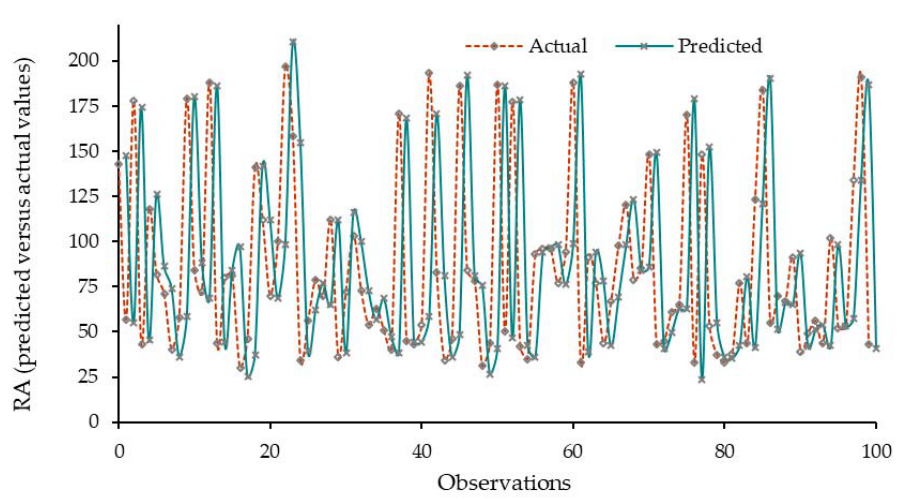
Figure 4. Scatter plot of the actual values and predicted values for one-hot encoding (100 testing instances randomly